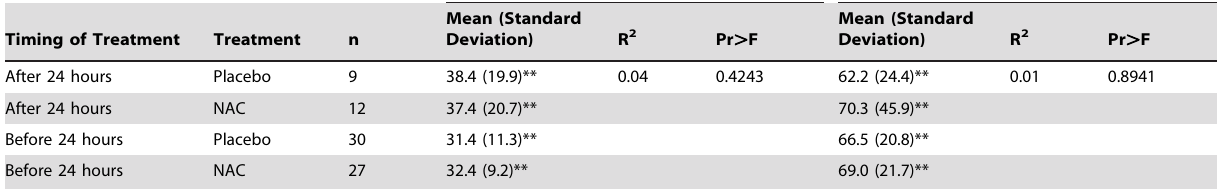
Trail Making A (seconds) – At entry to study Trail Making B (seconds) – At entry to Study Timing of